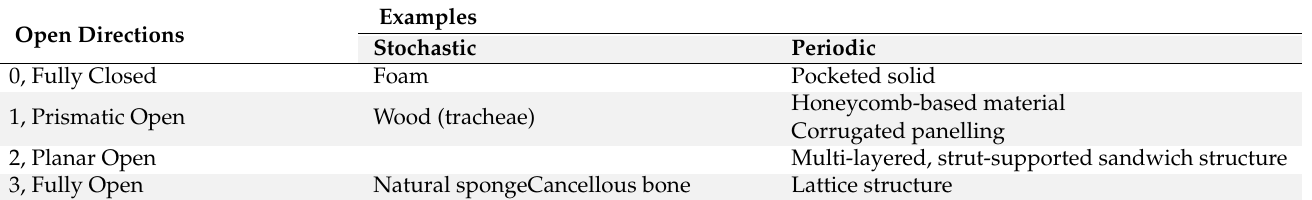
Table 1. Classification of cellular material topologies by open direction and